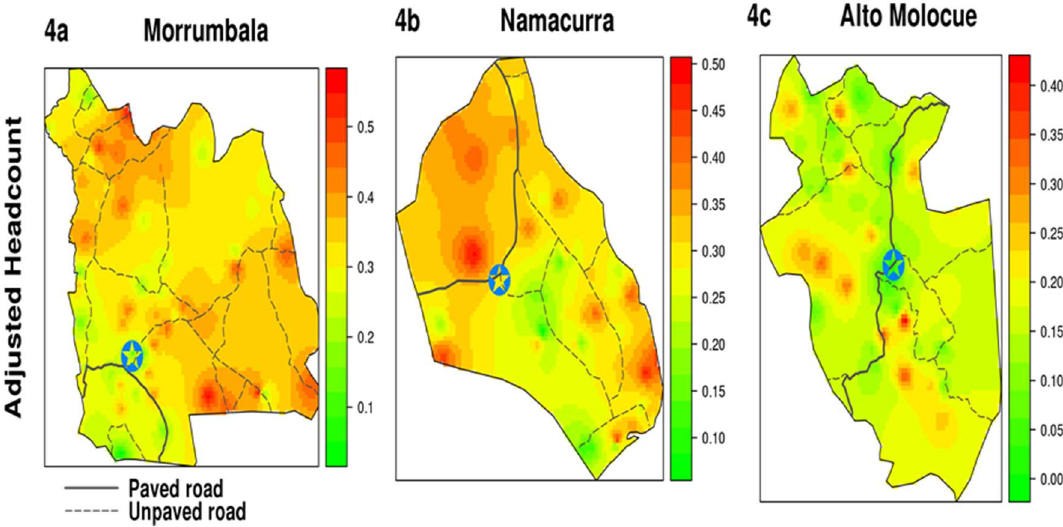
Figure 4. Smoothed Heat Map of Three Focus Districts: Morrumbala, Namacurra, and Alto Molo´cue`. *Figures 4a, 4b, and 4c show heat map geographical representations of poverty by adjusted headcount with green being less deprived and red most deprived. (Circled Star represents location of district capital).